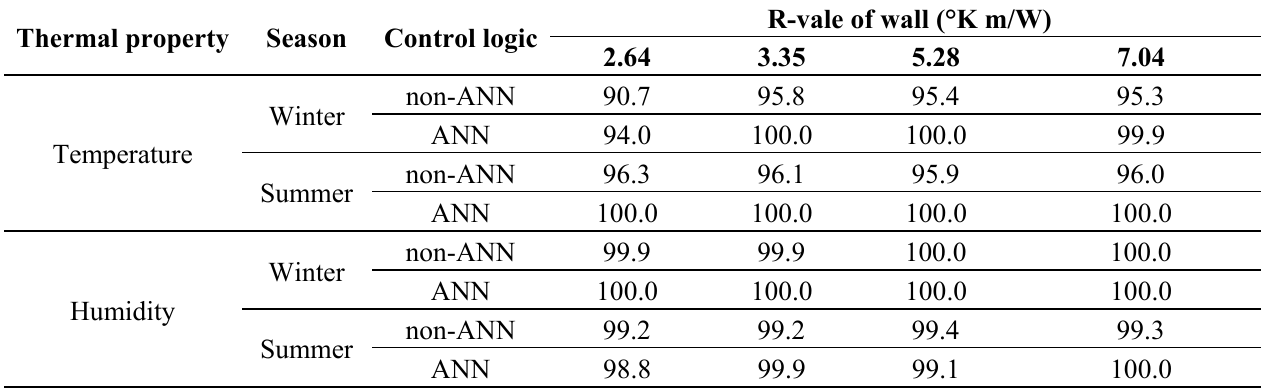
Table 5. Percentage of period within comfortable range according to R-value of wall (unit: %). Thermal property